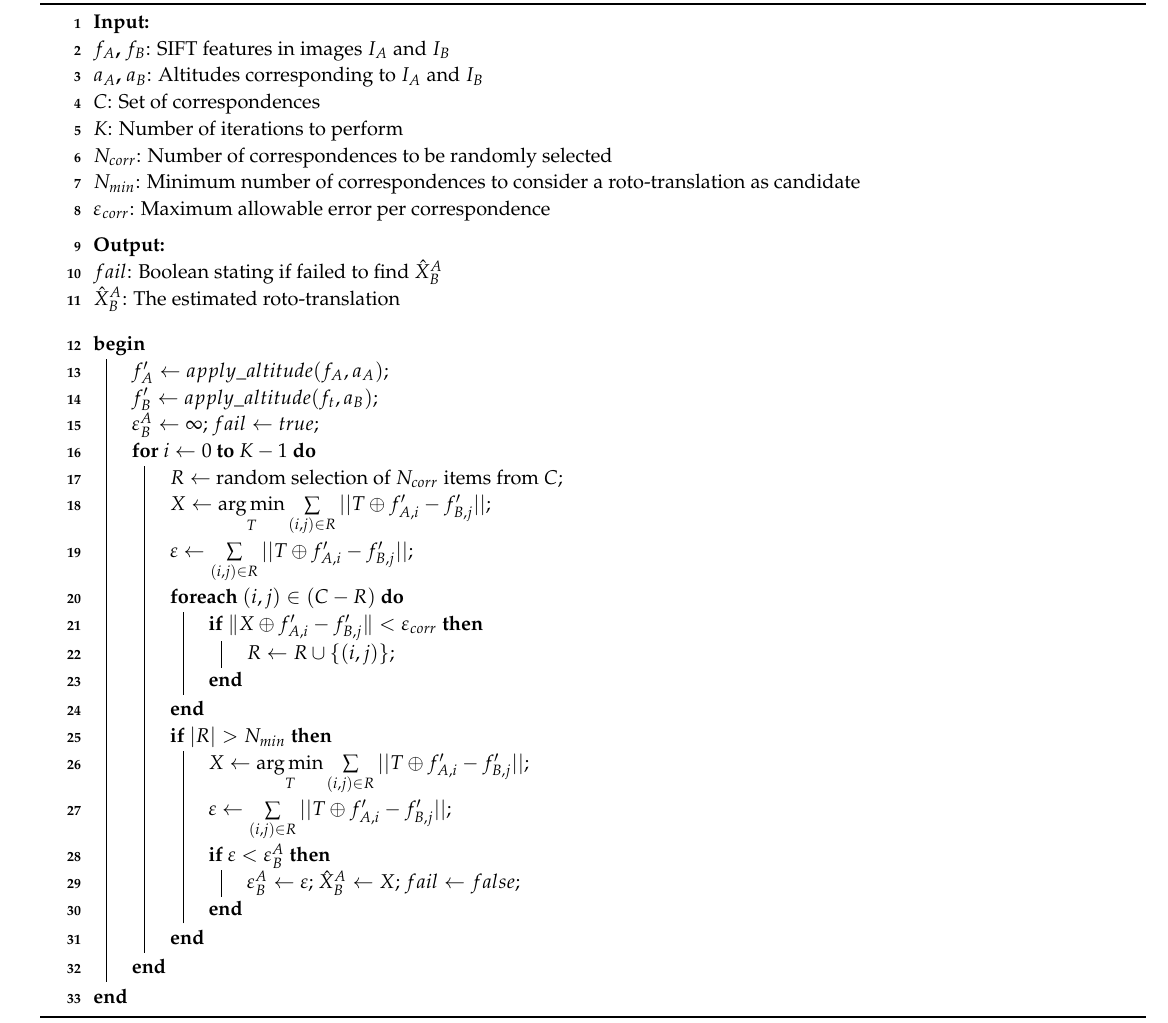
from image I A to image I B B